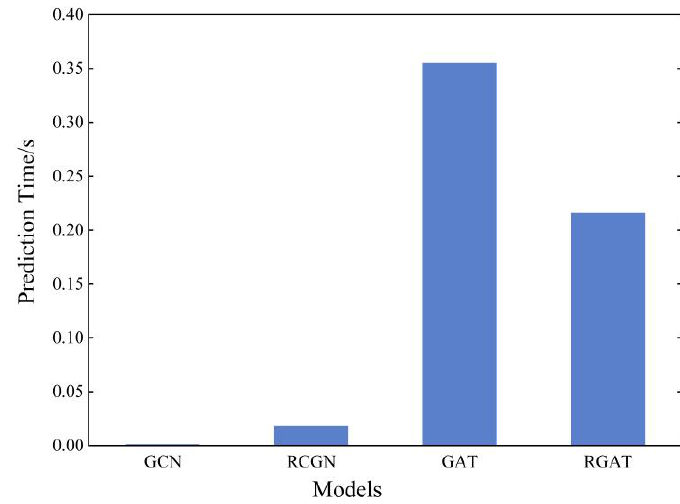
Figure 3. Prediction times for different models.